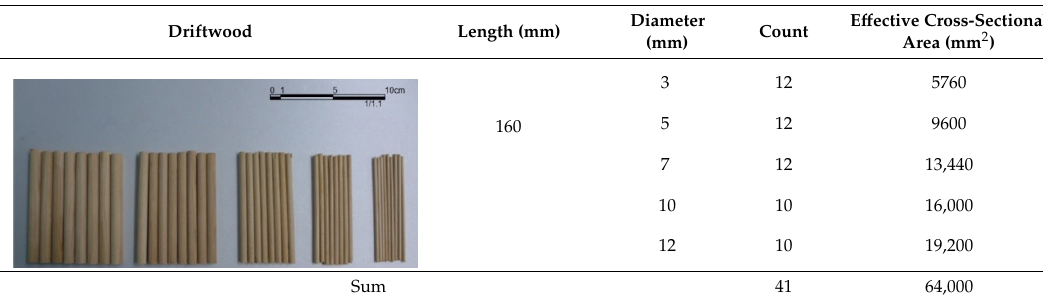
Figure 5. Driftwood capture trellis for agricultural drainage ditches: ( a ) driftwood capture trellis (plan); ( b ) photograph of the implemented driftwood capture trellis. Table 5. Driftwood types and specifications.